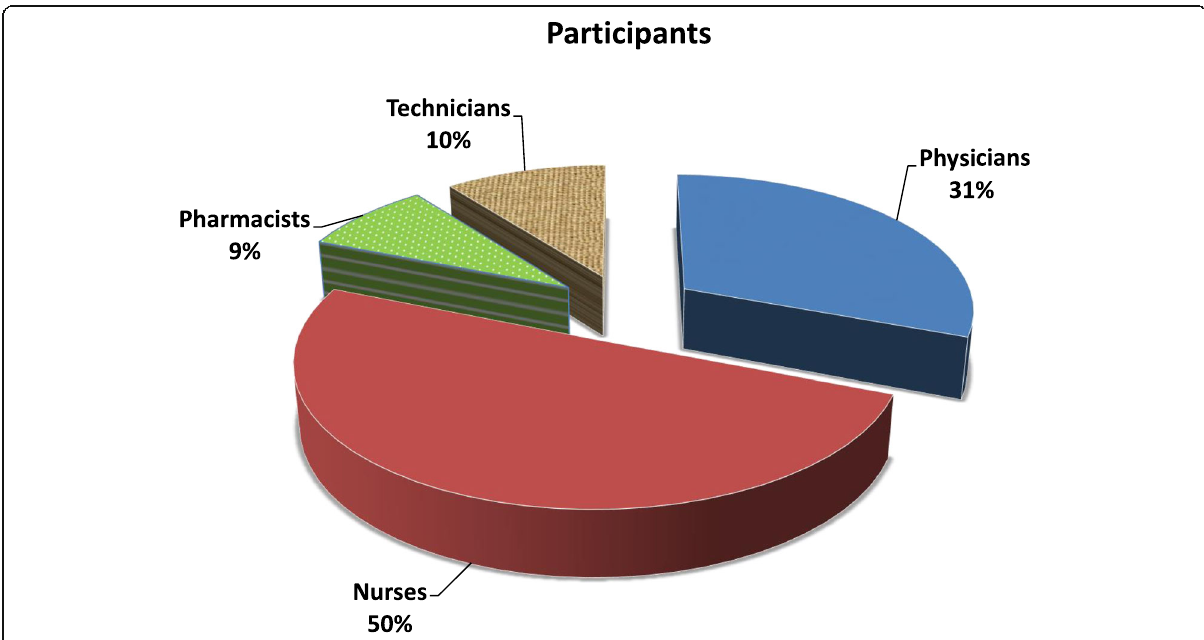
Fig. 1 Frequency distribution of the studied participants (medical and paramedical) ( n = 364)